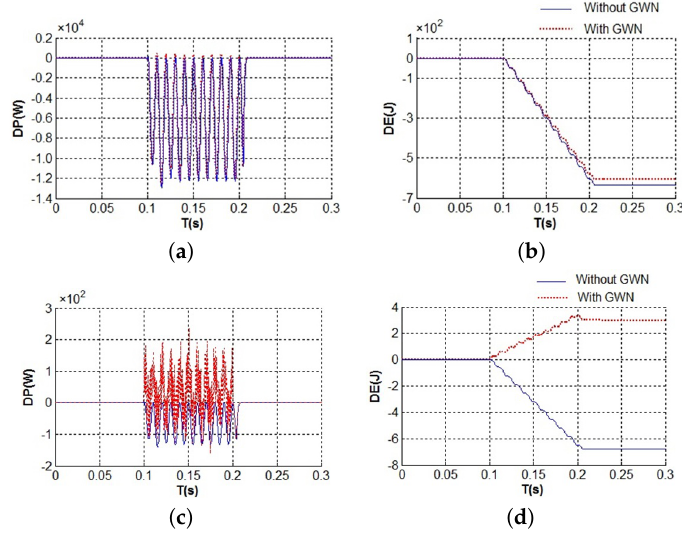
Figure 4. Effects on direction-judgments with different disturbance intensities. ( a ) DP at M 4 ; ( b ) DE at M 4 ; ( c ) DP at M 8 ; ( d ) DE at M 8 .